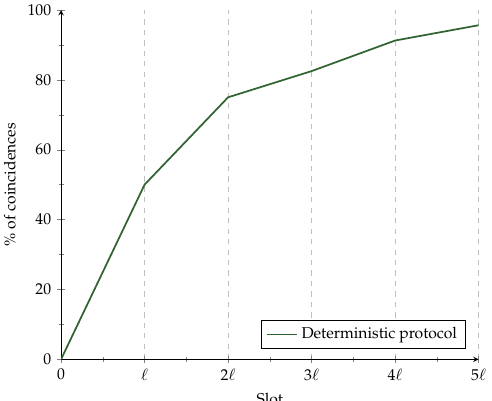
Figure 3. Fixed interval behavior of deterministic